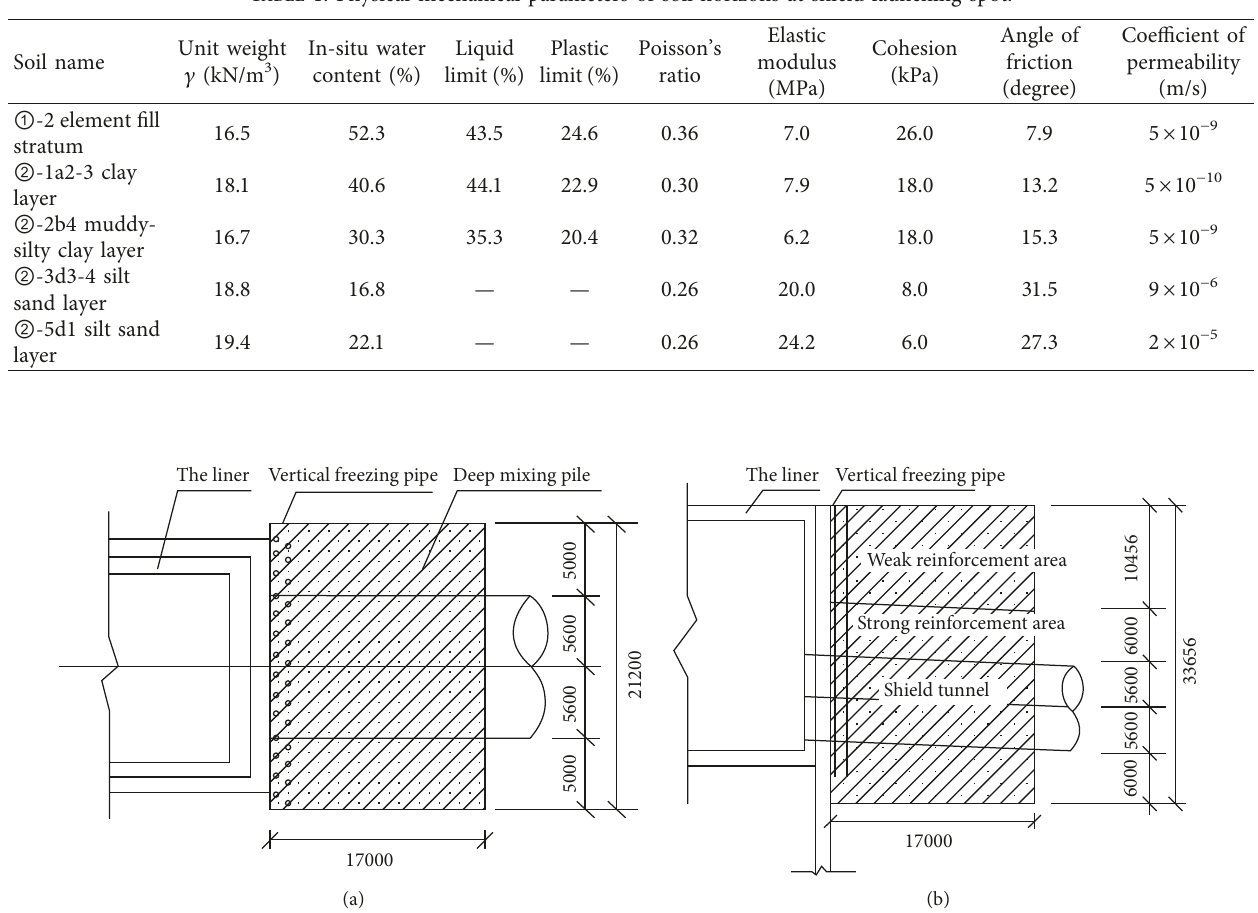
Table 1: Physical-mechanical parameters of soil horizons at shield launching spot.